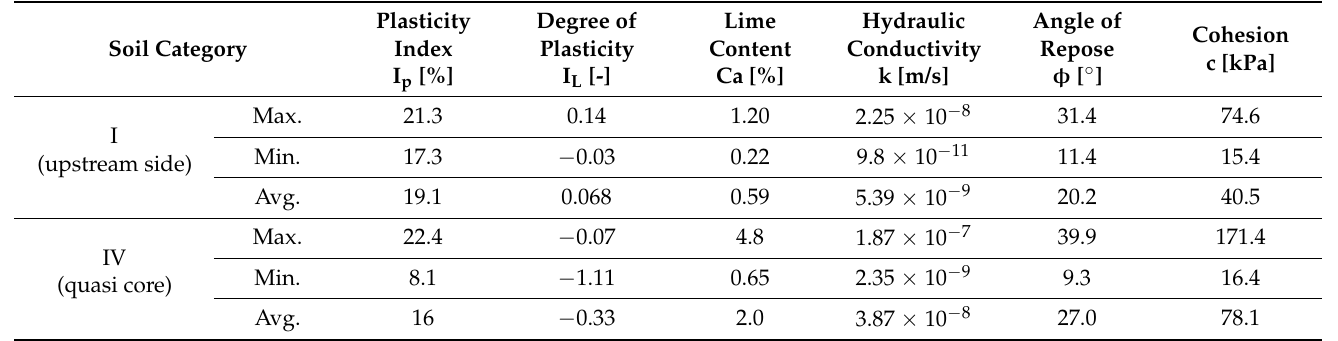
Table 6. The properties of soils taken from the upstream side and quasi core of the dam body